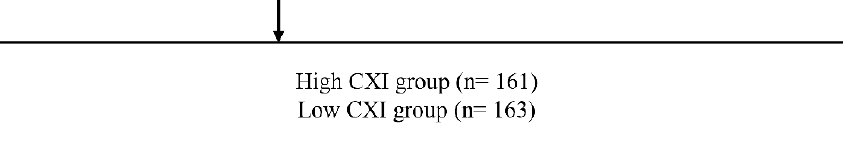
Figure 1. Flow diagram of patients.